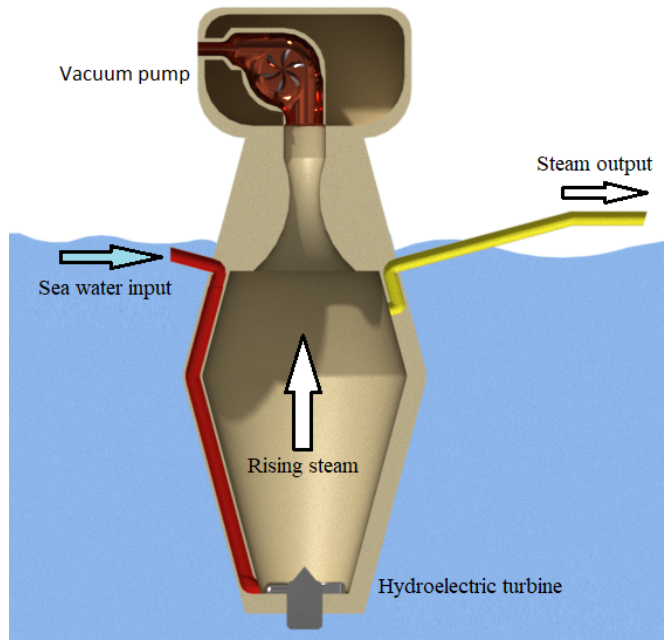
Figure 2. OTEC with Mist Lift